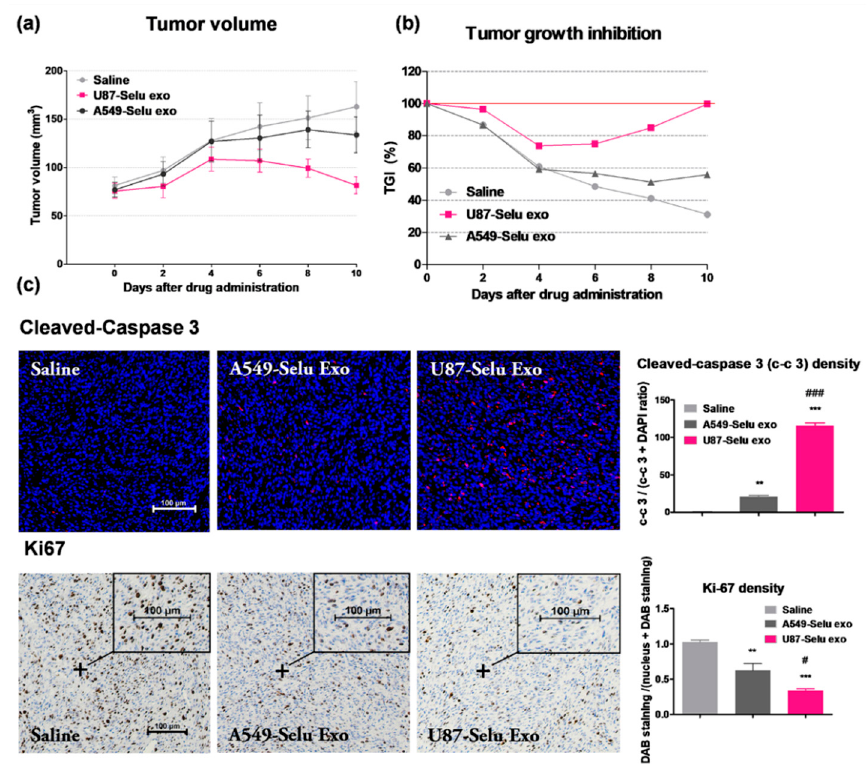
Figure 11. Anticancer effects of U87-Selu exo and A549-Selu exo in vivo. ( a ) Tumor volume changes up to 10 days after tumor induction, n = 5. ( b ) Tumor growth inhibition changes up to 10 days after tumor induction (red line: 100 % TGI). ( c ) Cleaved caspase-3 and Ki67 immunohistochemistry images of tumor. ** p < 0.01, *** p < 0.001 vs. saline group; # p < 0.05 and ### p < 0.001 vs. A549-Selu exo, n = 3. Scale bar: 100 µm. Data represented as mean ± SD.